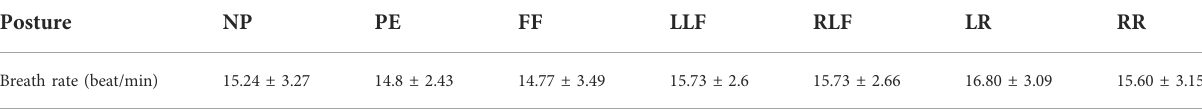
TABLE 5 Effects of different sitting postures on respiratory rate (n = 12). Posture